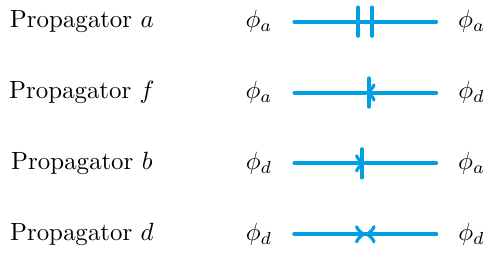
Figure 17. Propagators in the average-di(cid:11)erence basis.